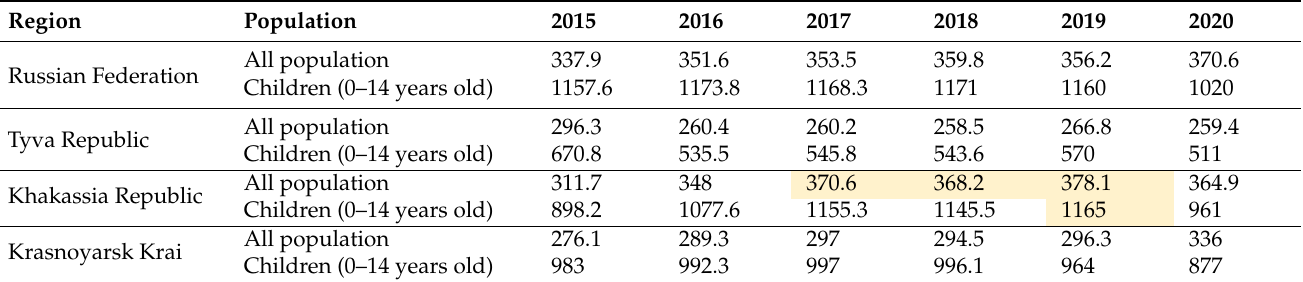
Table 6. Respiratory diseases morbidity of the population (registered diseases in patients diagnosed for the first time in their lives, per 1000 people). Source: Statistical Collection Health Care in Russia. Note: Cases exceeding the national average level are highlighted in